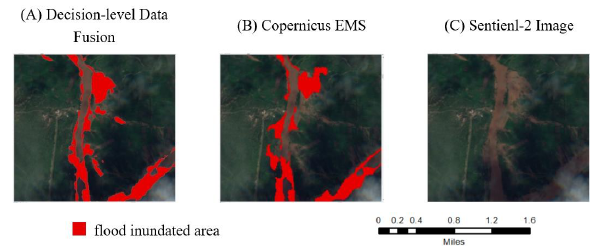
Figure 9 . Flood inundated areas in study area (partial) on February 27,